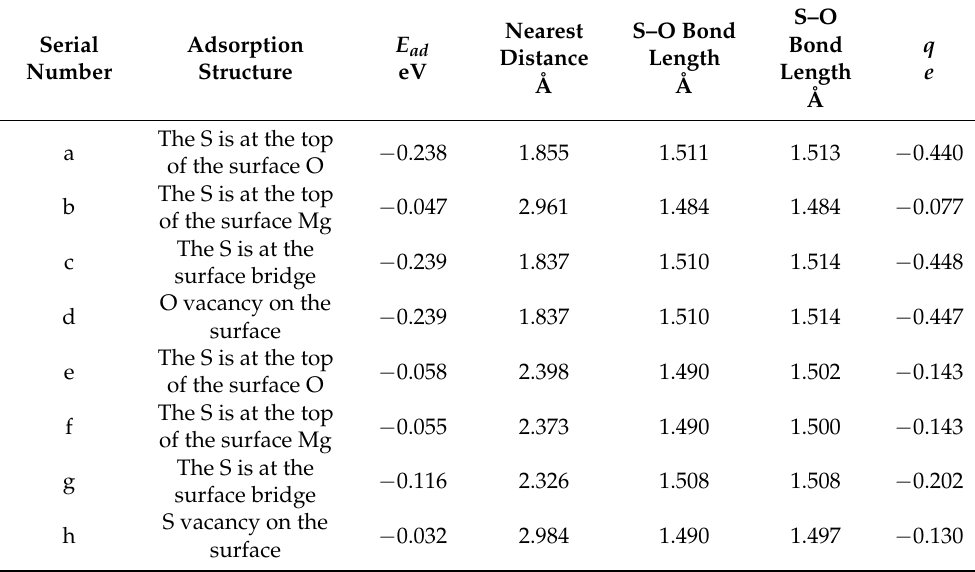
Figure 7. Stable adsorption structure of SO 2 molecules on the surface of MgO (100). ( a ) The S is at the top of the surface O; ( b ) The S is at the top of the surface Mg; ( c ) The S is at the surface bridge; ( d ) O vacancy on the surface; ( e ) The S is at the top of the surface O; ( f ) The S is at the top of the surface Mg; ( g ) The S is at the surface bridge; ( h ) S vacancy on the surface. Table 2. Adsorption energy, adsorption structure, and charge transfer of SO 2 adsorption on the surface of MgO (100).